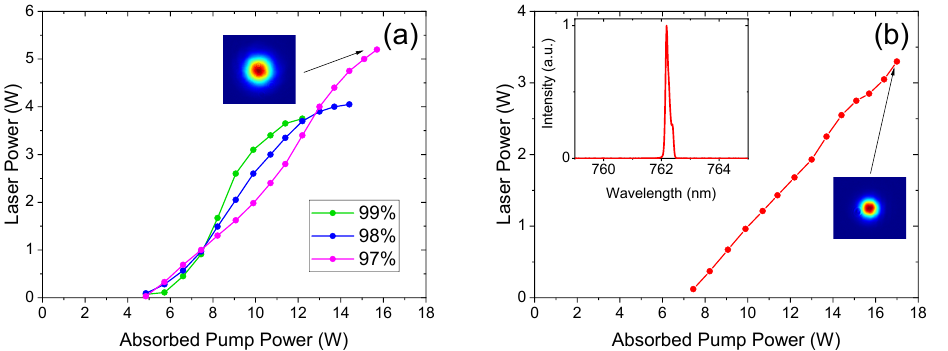
Figure 7. Laser power as a function of absorbed pump power for convex-plane cavity ( a ) with HR mirror ( b ) with